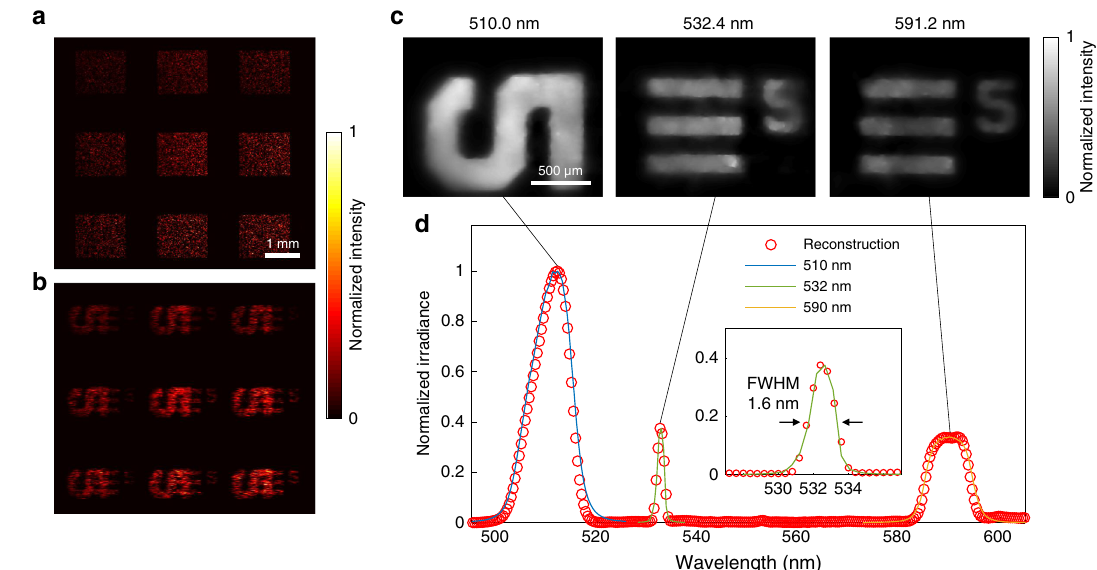
Fig. 4 ( x , y , λ ) imaging through compressed optical mapping. A hyperspectral datacube is spatially modulated by a coded aperture ( a ) and spectrally sheared by a dispersive element. b The spatially and spectrally encoded datacube is captured by a 2D image sensor. Computationally reconstructed hyperspectral images ( c ) and its averaged spectral irradiance ( d ).